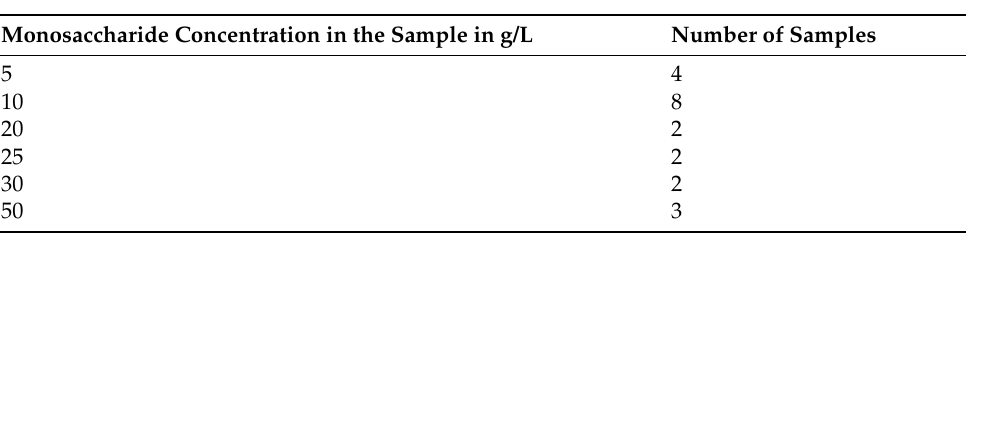
Table 1. Single monosaccharide samples: Number of analysed samples for each concentration of either glucose or fructose in an aqueous